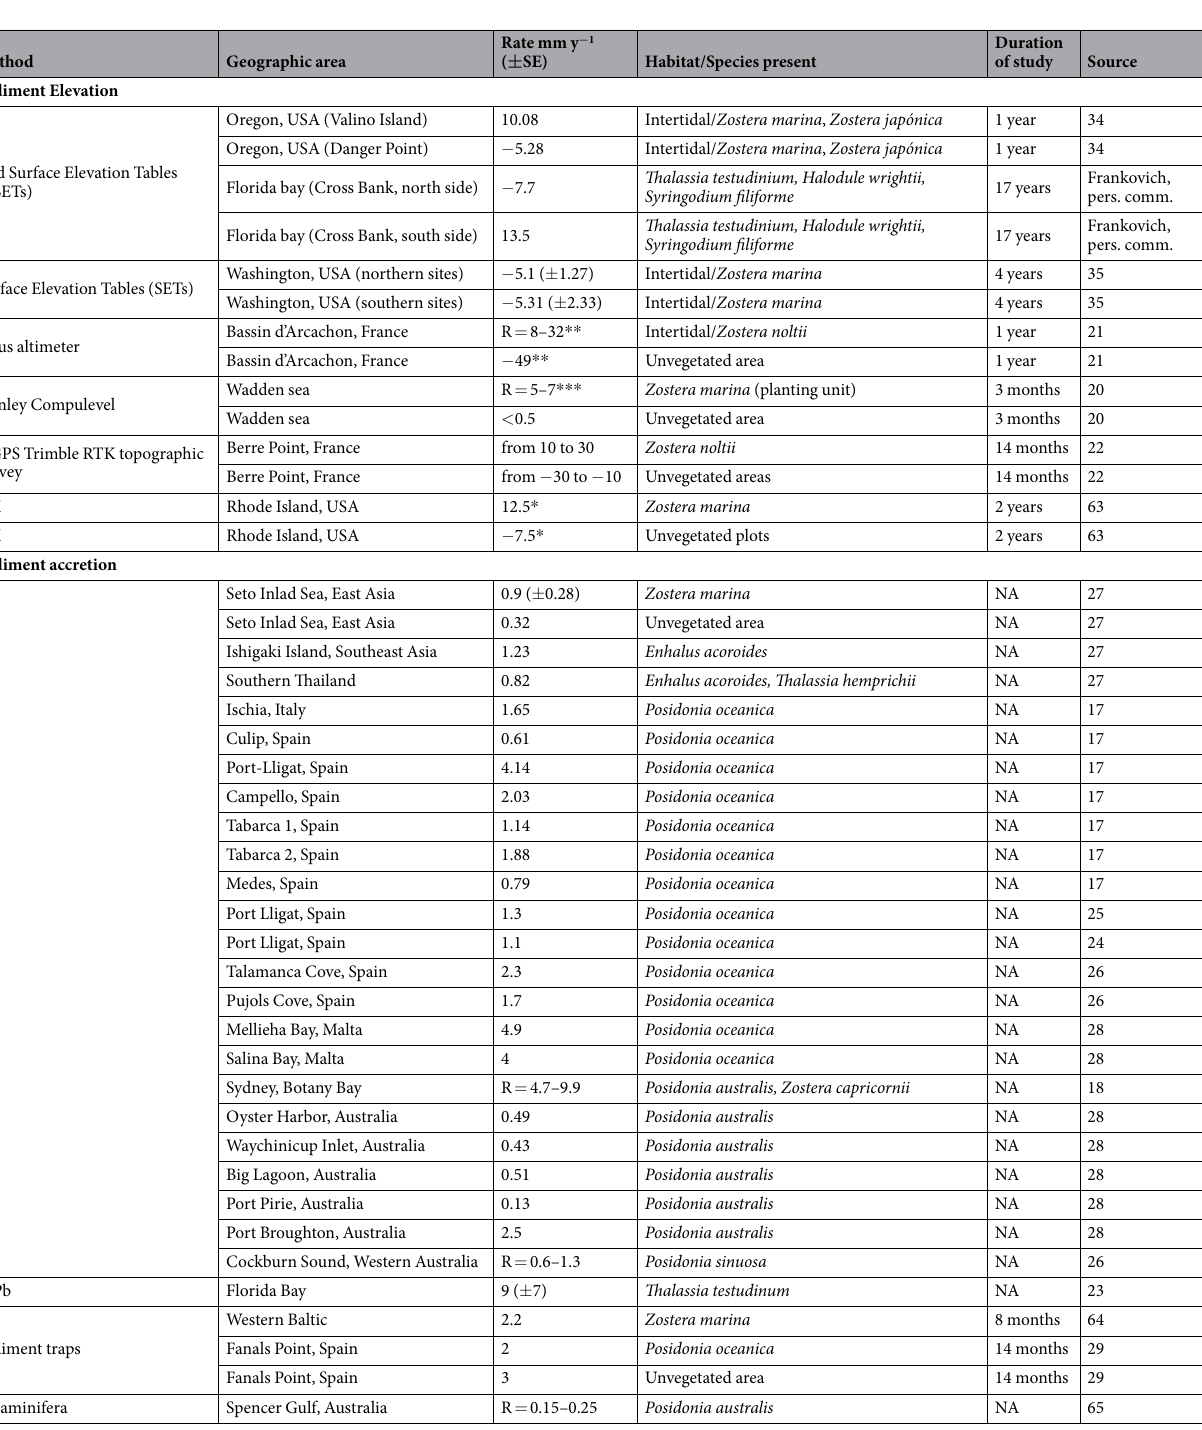
Table 1. Methods used to measure sediment elevation and accretion rates in seagrass meadows worldwide. * Ganthy et al . reported that between February and September of 2009, sediments were accreted at all seagrass stations ( + 41 mm, + 16 mm, + 15 mm for high density HD, medium density MD and low density LD plots respectively) whereas unvegetated showed minimal change ( + 3 mm). Between September 2009 and February 2010, sediments eroded at all seagrass stations ( − 9 mm, − 6 mm, − 7 mm for HD, MD and LD respectively), whereas the unvegetated station showed a strong erosion of − 54 mm. ** Harlin et al . reported 2.5 cm of accretion in seagrass plots, and 1.5 cm of erosion in denuded plots in the course of 2 years. *** Measurements reported for the growing season. NK: Not known, NA: Not Applicable, R: